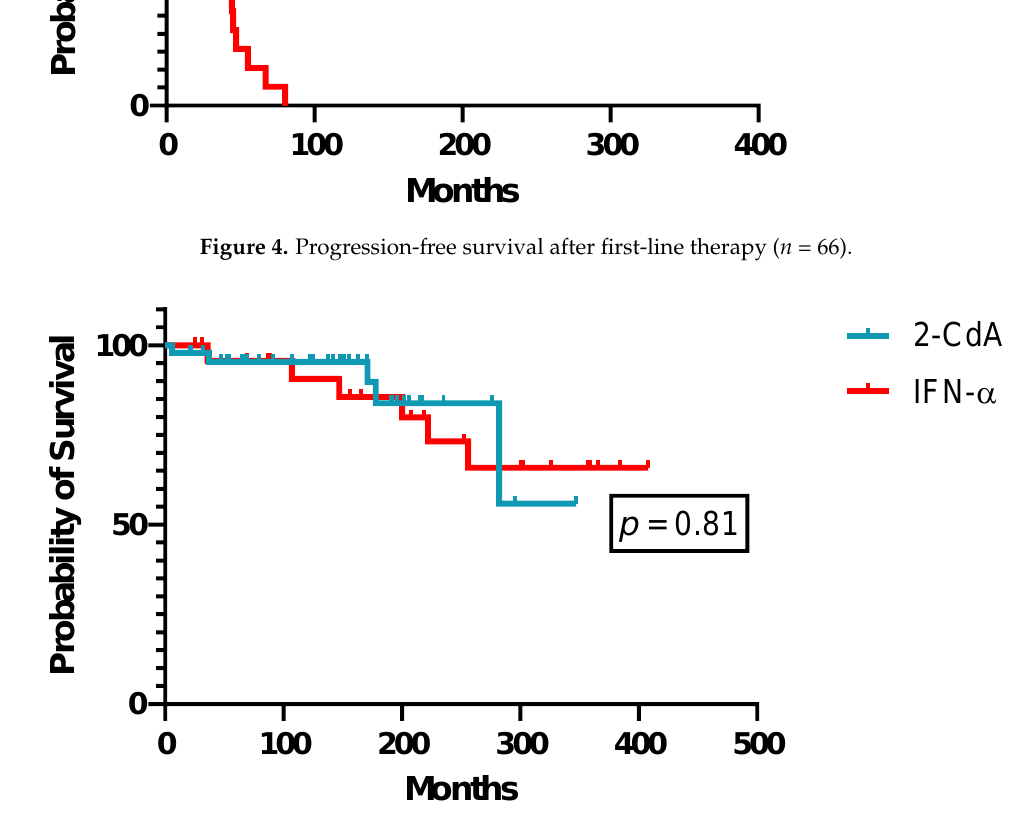
Figure 5. Overall survival according to first-line therapy ( n = 66).